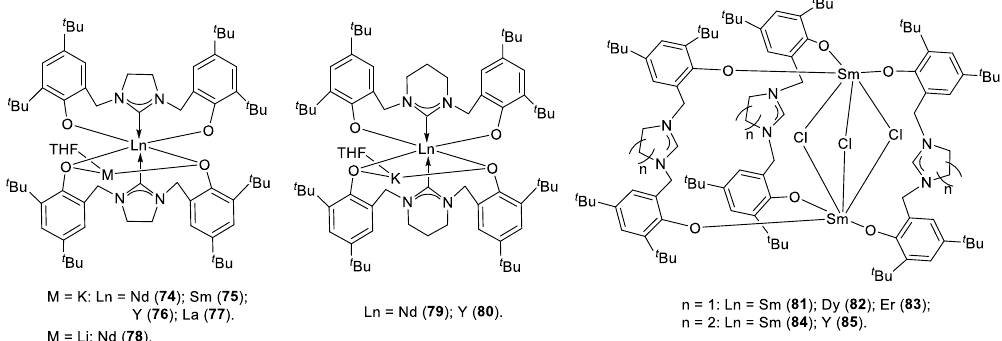
Figure 16. The Ln complexes bearing chelating bis(phenolate)-NHC ligands (BisP-NHC-5 and BisP-NHC-6) [81,82].